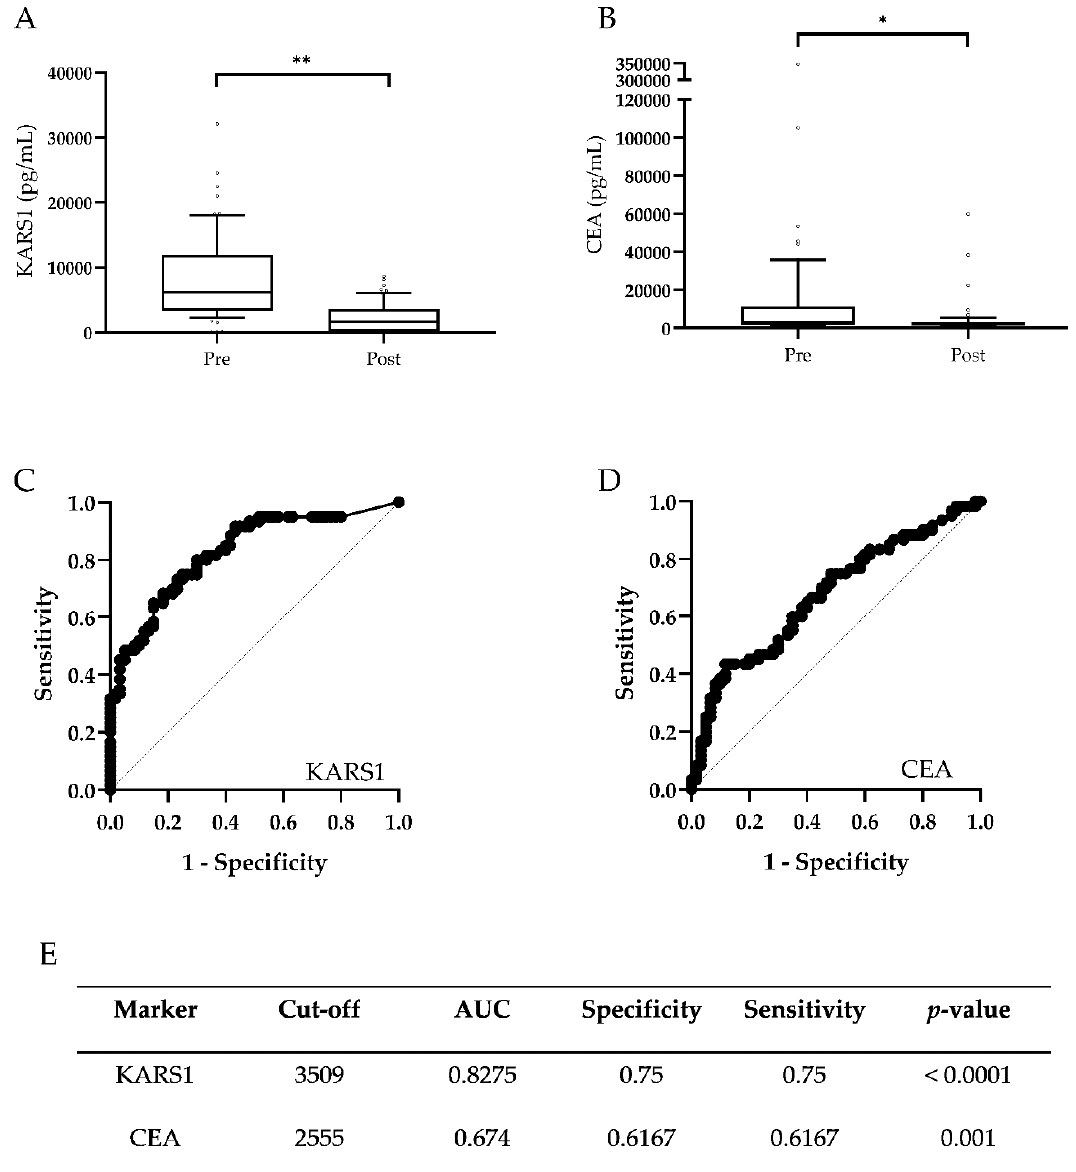
Figure 4. Monitoring values of plasma KARS1 in CRC. Levels of KARS1 ( A ) and CEA ( B ) in the plasma of paired pre- and post-surgery CRC patients ( n = 60) were monitored and shown as box and whisker plots. ROC curves for KARS1 ( C ) and CEA ( D ) were used to differentiate post-surgery CRC from the pre-surgery CRC group. ( E ) Summary of ROC analysis, including the cutoff value, area under the ROC curve (AUC), specificity, sensitivity, and p- value. * p < 0.05, ** p < 0.0001.